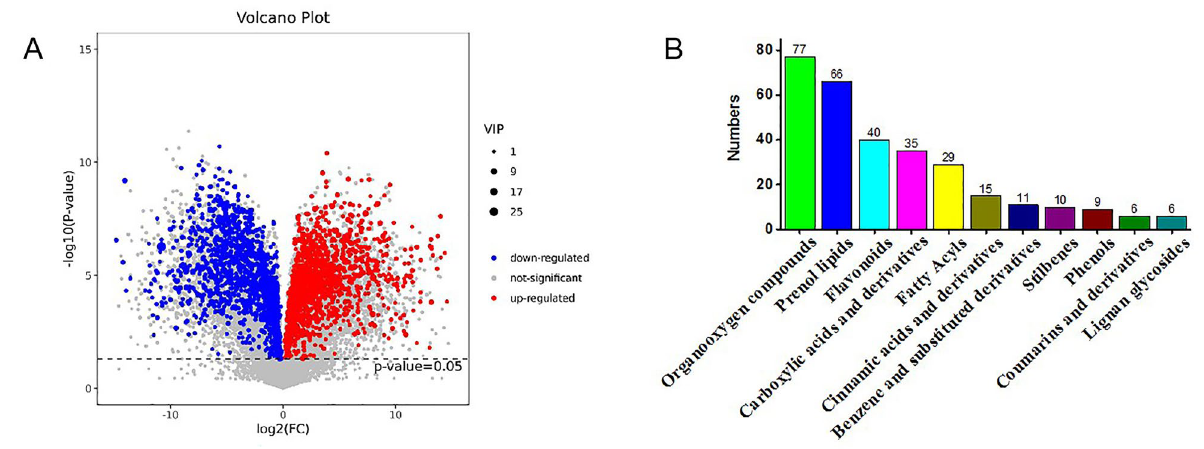
Figure 3. Differentially abundant metabolites between TPFD and FSD. ( A ): Volcano plot of the 2352 metabolites identified. ( B ): Main classes of differentially abundant